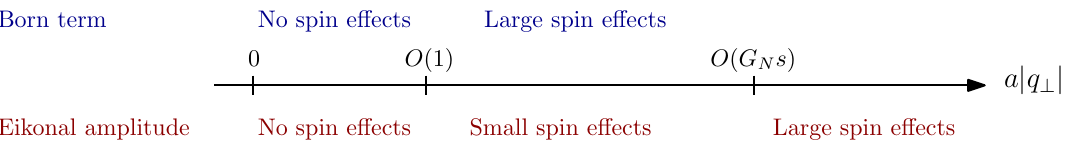
Figure 1 . Scales in a | q ⊥ | at which spin effects occur for the Born and eikonal amplitudes of the BN